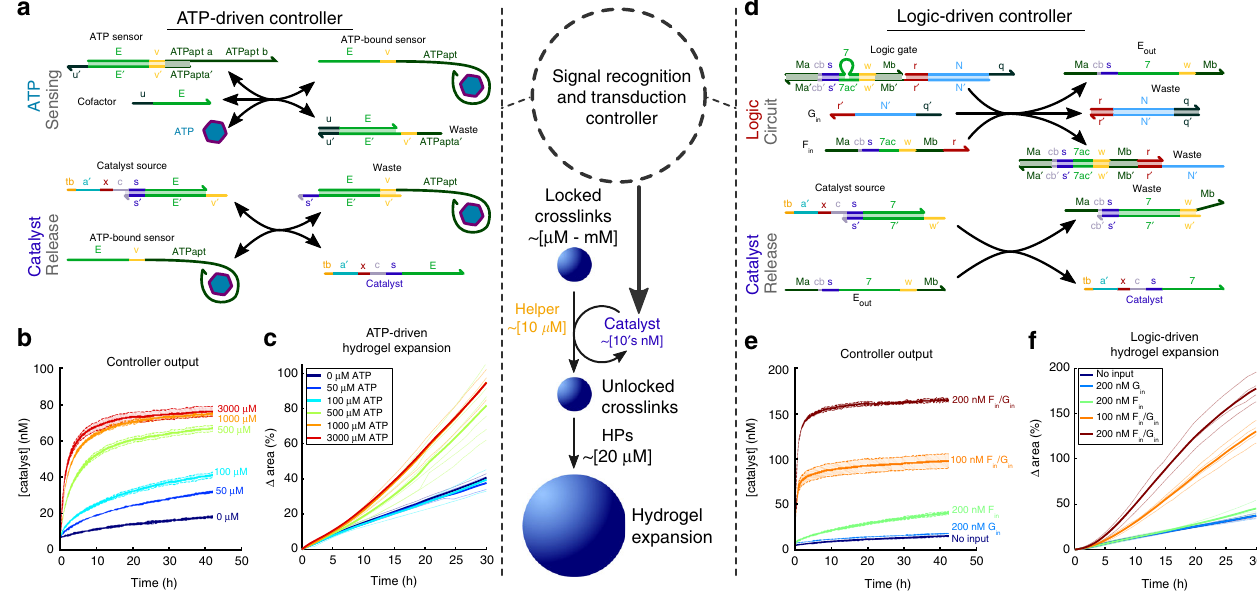
Fig. 5 Controllers that direct hydrogel expansion in response to different types of chemical inputs. a An aptamer-containing strand-displacement circuit that releases Catalyst in response to ATP. b Solution kinetics of the circuit in ( a ) measured using fl uorescence reporting (see Methods, Supplementary Fig. 19) in response to different ATP concentrations. ATP sensor, Cofactor, and Catalyst source initially at 100 nM. c ATP-controlled rates of particle swelling mediated by the circuit in ( a ), catalytic crosslink unlocking (Fig. 3a), and hairpin polymerization (Fig. 1c). Sensor, Cofactor, and Catalyst source at 100 nM; Helper strand at 10 µ M. d DNA strand-displacement AND logic circuit. Two inputs, F in and G in , are required for Catalyst release. e Kinetics of the logic circuit in ( d ) in solution measured by fl uorescence reporting. The logic gate and Catalyst source are at 200 nM. f Particle expansion in the presence of different F in and G in concentrations. Logic gate and Catalyst source are at 200 nM; Helper at 10 µ M. N = 3 ( b , e ) or 2 – 6 c , f . Shaded regions ( b , e ) represent 95% con fi dence intervals determined by standard deviations; dotted lines in ( c , f ) are replicate measurements with the averages represented by solid fl uorescence upon reaction with DNA strands containing the Catalyst sequence Synthesis of poly(DNA- co -acrylamide) hydrogel particles . DNA crosslinks and toehold (Supplementary Fig. 19). The measured fl uorescence increase was were mixed to a fi nal concentration of 1.154 mM with water, ×10 TAEM, acryla- converted into the concentration of Catalyst strand using a calibration curve. The mide, rhodamine methacrylate, and Irgacure 2100 (75% v/v in butanol). The fi nal DNA strand-displacement logic circuit was tested using 200 nM Source complexes concentrations of acrylamide, rhodamine methacrylate, and Irgacure 2100 were and 200 nM Reporter. Aptasensor circuits were tested at 100 nM Source complexes, 1.41M, 2.74 mM, and 3% (v/v), respectively. After mixing, the pre-polymer solu- 100 nM Cofactor strand, and 200 nM Reporter. PolyT 20 (1 µM) was added to tions were degassed under vacuum for 5min. Pre-polymer droplets were prepared using a water-in-oil method (Fig. 2a). Mineral oil USP (CVS Pharmacy) “ wells ” inhibit adsorption to well walls. were prepared on a cratered para fi lm surface and pre-polymer droplets were added using a pipette set to 0.25µL. Droplets were exposed to 365 nm light using a Benchtop 3UV Transilluminator (UVP) for 1 min (~4mW/cm 2 ) to polymerize and crosslink the particles. Particles were puri fi ed from the oil using centrifugation into TAEM and were stored at 4°C until use, usually within 1 week. Swelling of DNA-crosslinked hydrogels . Swelling experiments were conducted in 96-well plates (Fisher Scienti fi c) with one particle per well. Micrographs of particles were taken on an IX73 Olympus fl uorescence microscope using a rhodamine fi lter. The fi nal volume of liquid in each well varied between 100 – 120µL, depending on the experiment. For experiments with locked particles, the particles were incubated with DNA hairpins (20 µM/hairpin type, 10% terminator) for about 24h prior to the addition of Catalyst/Helper strands or circuit complexes. For all experiments with DNA circuits, the Helper strand concentration was 10µM. Images of each particle were captured every 30 min. Particle area measurement and analysis . Images of the fl uorescent particles were considered to be accurate 2D projections of the particle size near the center xy - plane. To decrease the sensitivity and bias involved in measuring the diameter, especially of an irregular or non-circular projection, the area of the 2D projection was chosen as the representative variable of particle size and calculated as a function of time for each particle. The area was determined using standard intensity-based thresholding and mask image analysis using MATLAB (Supple- mentary Note 2). Area measurements for each particle were normalized to the initial time point. The curves showing the change in size as a function of time are taken from measurements made every 30min, averaged over multiple particles. The curves were smoothed with a window size of 3.